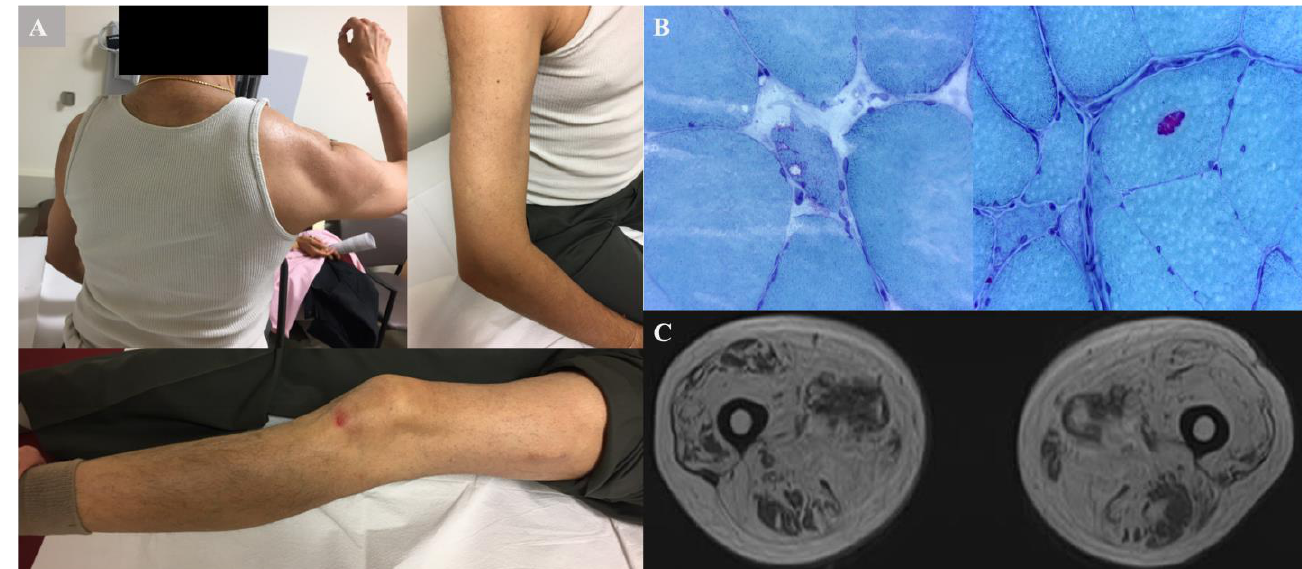
Figure 2. Clinical signs, biopsy, and MRI findings from proband 1 (III:3): ( A ) bilateral scapular winging prominent on the right, with humeral muscle atrophy and bilateral thigh muscle atrophy; ( B ) thigh biopsy stained with modified Gomori Trichrome on a cryosection, where variability in the muscle fiber size with areas of fiber size variation and vacuoles can be seen; ( C ) MRI of bilateral thighs demonstrating prominent atrophy and fatty replacement in both the anterior and posterior compartments.